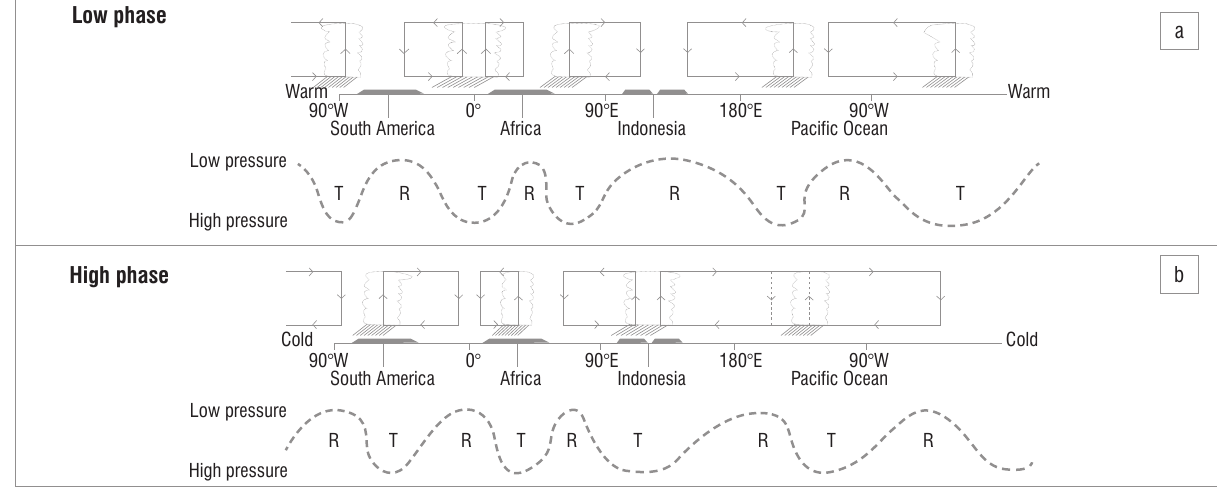
Figure 3: East to west globally encircling Walker circulation centred on the meteorological equator resulting in a trough (T)–ridge (R) oscillation in the surface pressure fields with accompanying wet (rain) and dry (drought) regions extending globally around the equator. The low phase (a) occurs when the far eastern Pacific warms (El Niño). The high phase (b) occurs when the far eastern Pacific cools (La Niña).